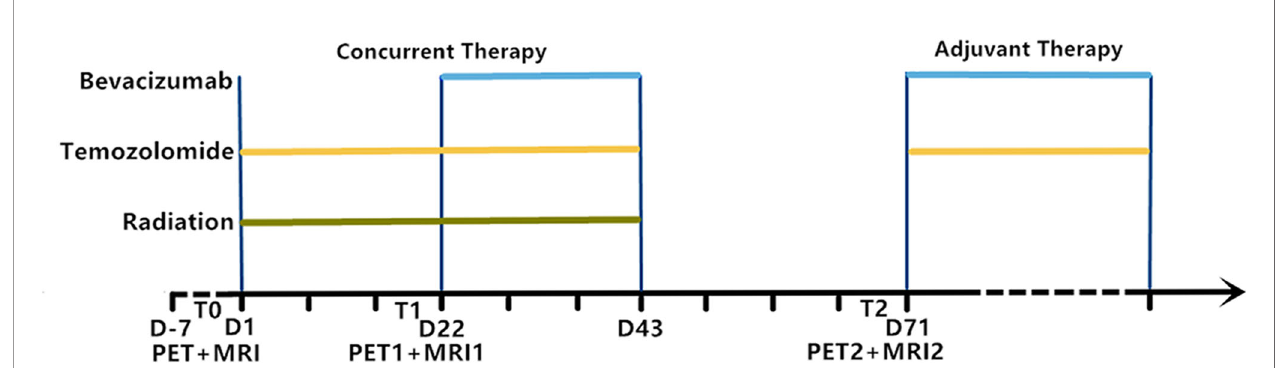
FIGURE 1 | Experimental timeline showing relative timing of radiation, temozolomide and bevacizumab treatment as well as 18 F-RGD PET and DCE-MRI image acquisition. T 0 , baseline; T 1 , week 3; T 2 , week 10;